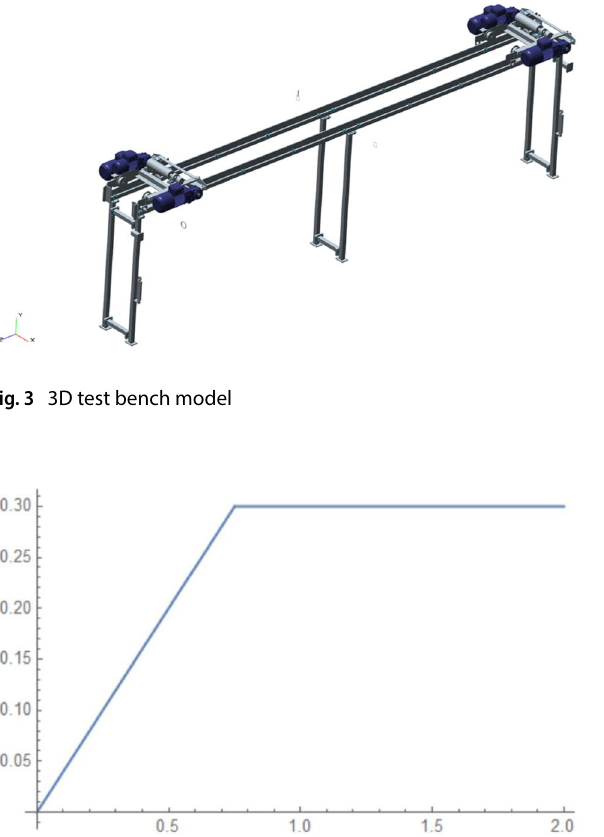
Fig. 4 Input velocity